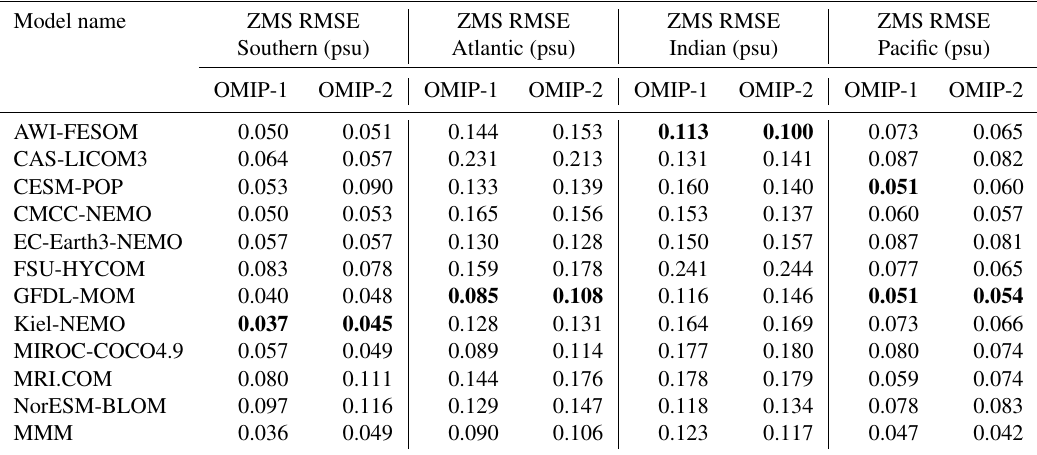
Table D6. Same as Table D5 but for zonal mean salinity (psu).